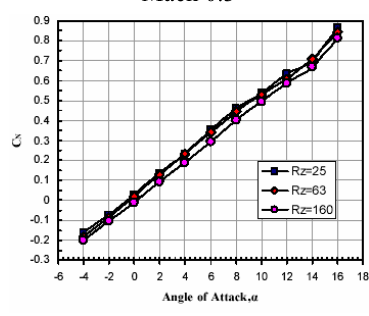
F ig.13Comparison of lift over drag at Mach 0.3